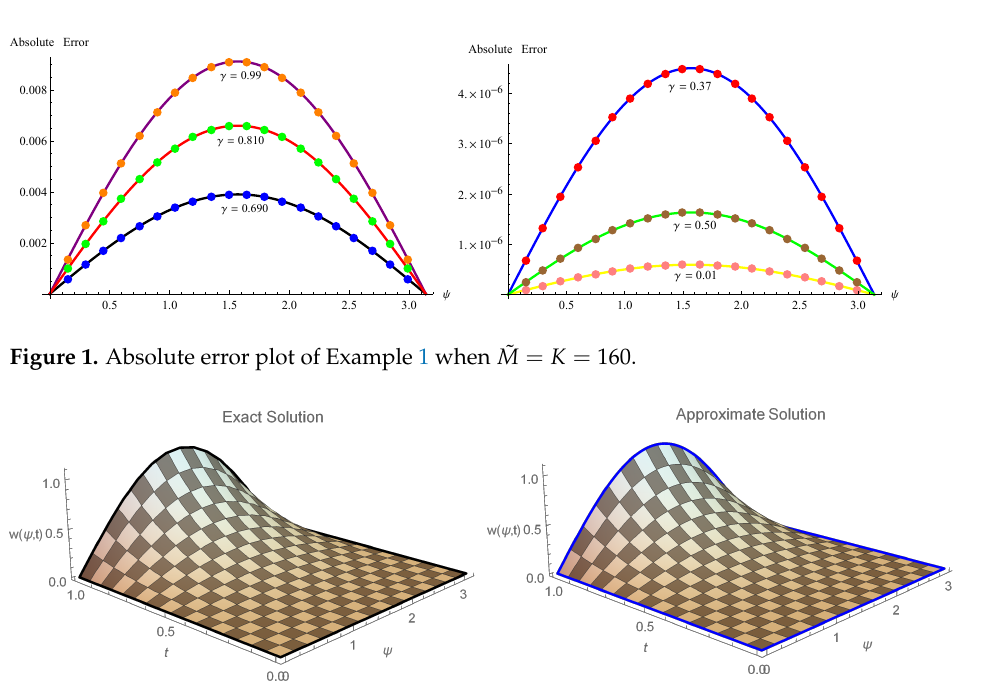
Figure 2. Three-dimensional space–time plot of analytical and approximate solutions when γ = 0.37, ˜ M = K = 80.